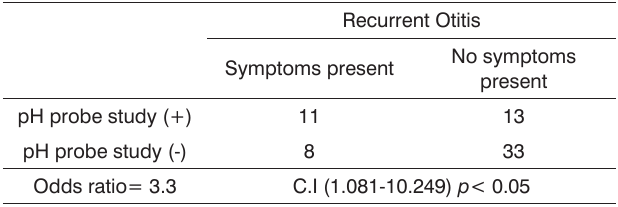
Table 3. Recurrent otitis and their association with the pH probe study